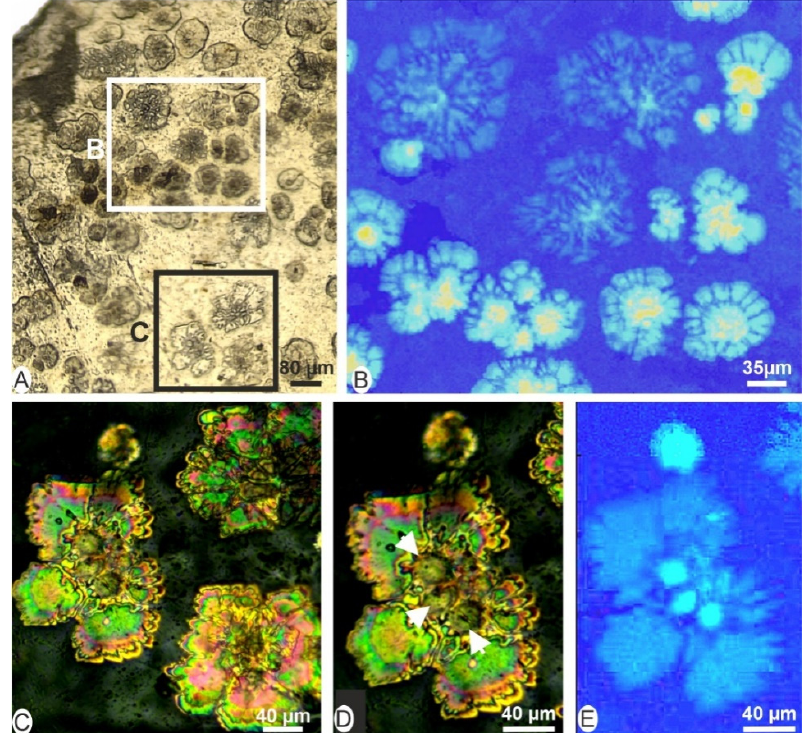
Figure 2. Example of initial mineralizations by the pearl sac; ( A ) Overall view of the detached fragment. ( B ) Morphological diversity of the minerals viewed by calcium fluorescence. ( C , D ) Po- larized light microscopy of the minerals from area C in ( A ). Note the similarity in marginal growth. ( E ) Calcium fluorescence of unit shown in ( D ).